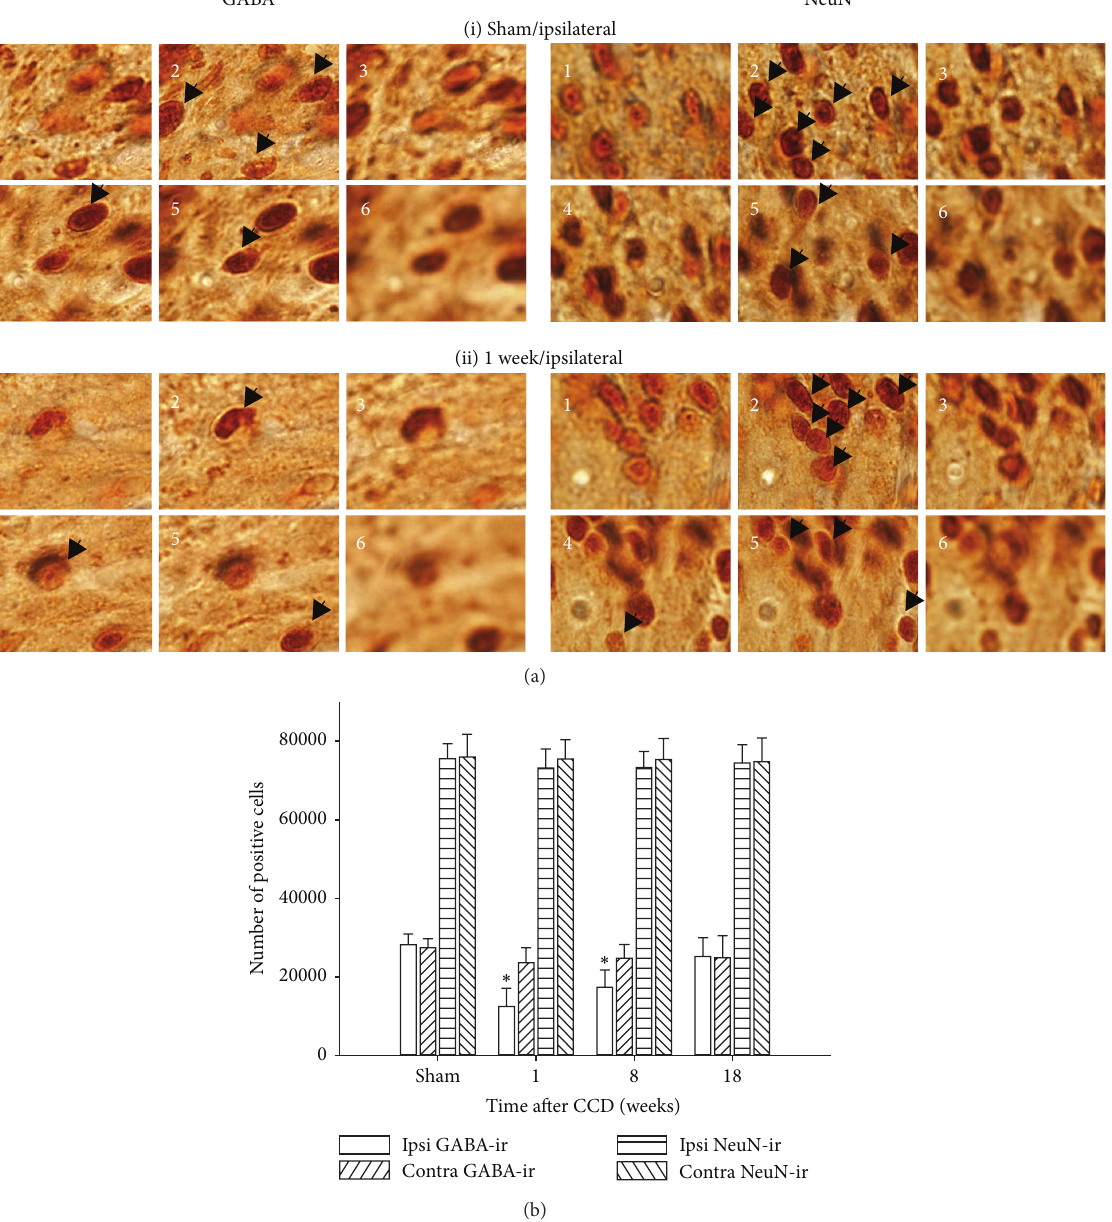
Figure 3: Quantitative analysis of GABA-ir and NeuN-ir cells by stereological cell counting. In (a), images used for stereological cell counts are shown, taken at six consecutive focal planes from the top to the bottom of the 20 𝜇 m optical dissector. The dissector contains 5 GABA-ir and 9 NeuN-ir cells for the sham-operated group (i) and 3 GABA-ir and 10 NeuN-ir cells for the 1-week post-CCD group (ii) (indicated by arrows). In (b), the mean numbers of cells estimated by stereological analysis from L4-L5 dorsal horn laminae I–III of individual animals are represented in bar graphs ( 𝑛 = 5 rats for each group). The number of GABA-ir cells significantly decreased for both 1-week and 8-week post-CCD groups compared with the sham-operated group, whereas no significant differences in NeuN-ir cell number were seen among all four groups. ∗ 𝑃 < 0.05 when compared with sham-treated